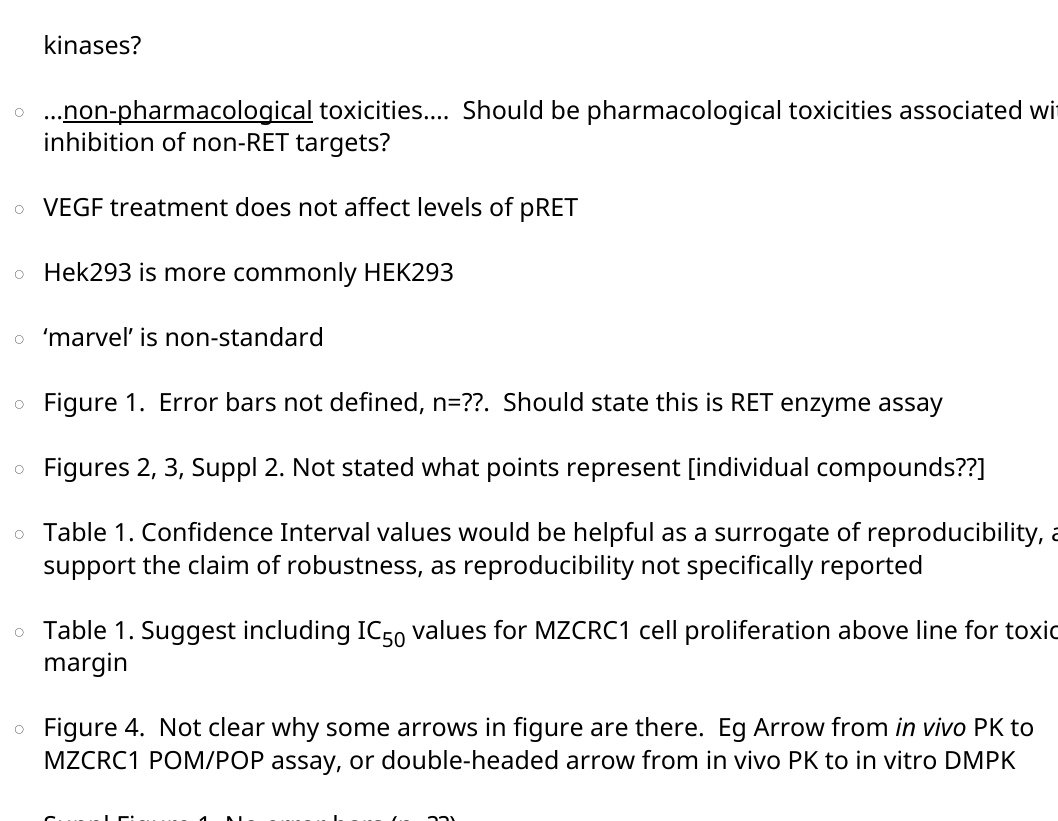
Suppl Figure 1. No error bars (n=??)